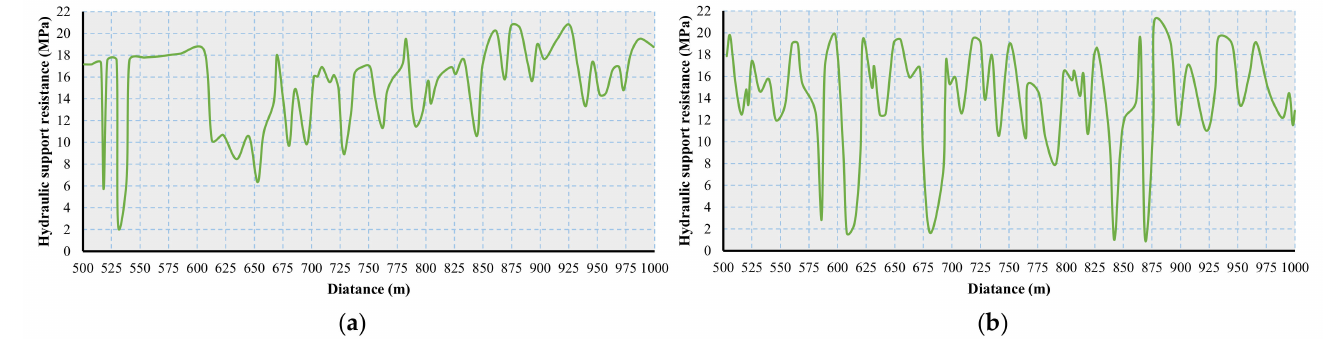
Figure 17. Curve of the support resistance of 42,115 working face under the interchange bridge area. ( a ) Resistance of 80 # hydraulic support; ( b ) Resistance of 90# hydraulic